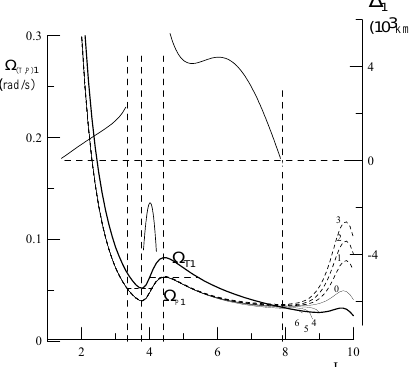
The upper curve displays the dependency of equatorial distance between the Fig. 4. Dependency of the toroidal (thick lines) and poloidal (thin lines) poloidal and toroidal resonant shells. eigenfrequencies (cid:10)TN(x1);(cid:10)PN(x1) on the magnetic shell parameter , and Fig. 3. Dependency of the toroidal and poloidal eigenfrequen- PN for the first five longitudinal harmonics ( ), in the source cies (cid:127) TN (x 1 ), (cid:127) PN (x 1 ) (the lower curves) on the magnetic shell L N=1;:::;5